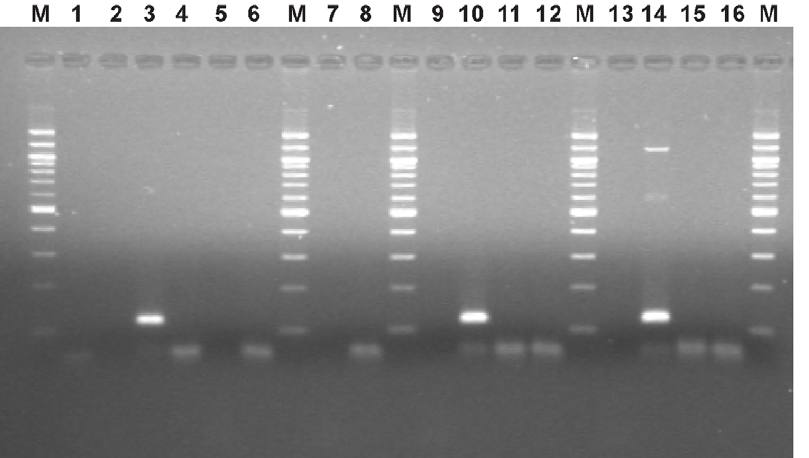
Figure 3. Amplification of the 119-bp fragment of the 5 9 UTR of the 15-kDa lipoprotein gene of T.pallidum , from DNA extracts obtained at the UAC¸. M, molecular weight marker, 100 bp DNA ladder (Sigma); 3, ELS 551; 10,14, ELS 558; 1,2,4,5,7,9,11,13 unaffected ancient samples; 6,8,12,15 extraction blanks (KE); 16, PCR blank.